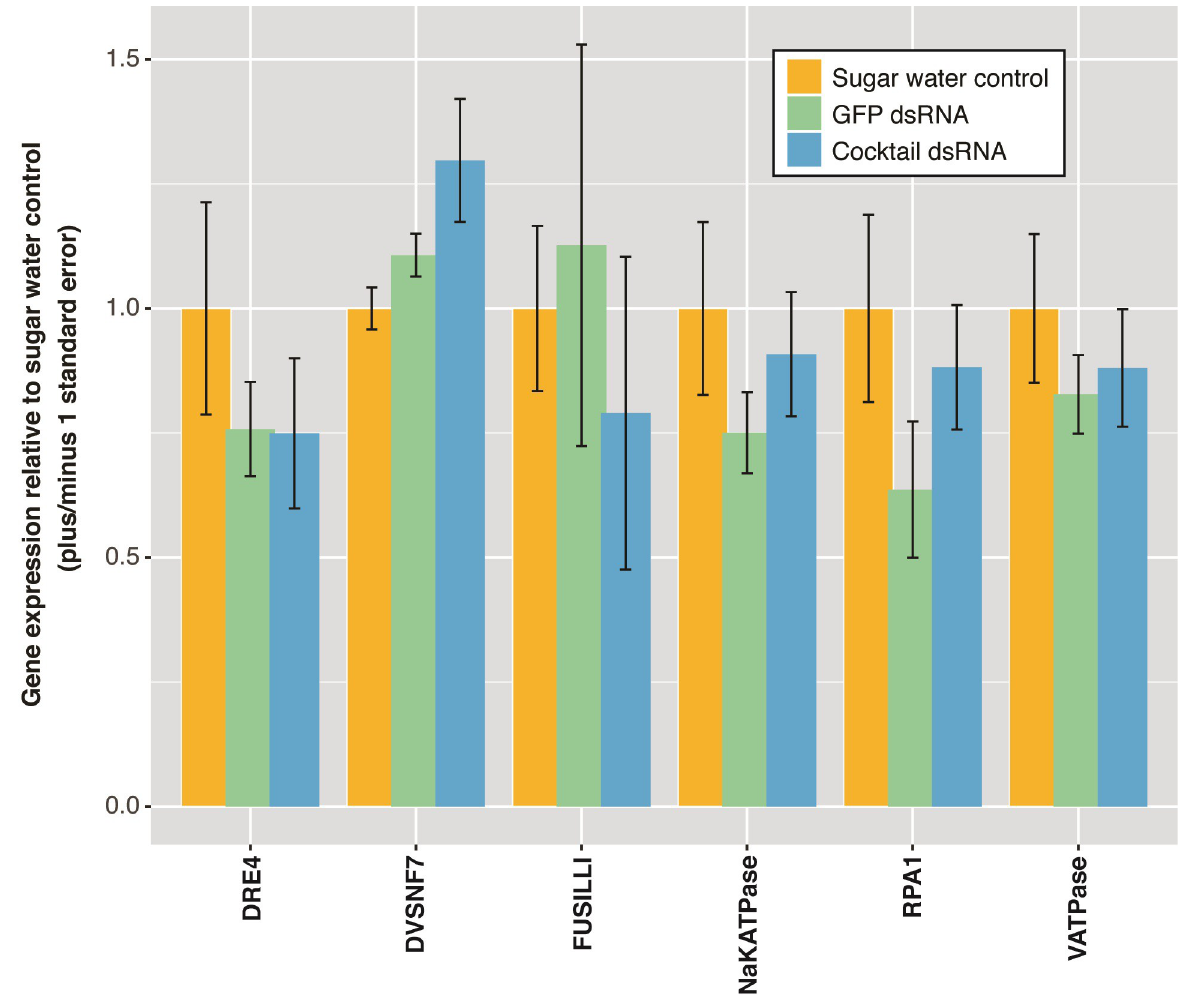
Fig 6. Relative gene expression of P . dominula foragers provided dsRNA while able to access to and tend for their nests of origin, in a set up mimicking more natural conditions. Bars correspond to the pooled mean ± SE for six wasps (randomly selected) in each dsRNA treatment, compared to three wasps fed GFP dsRNA and three control wasps fed sugar